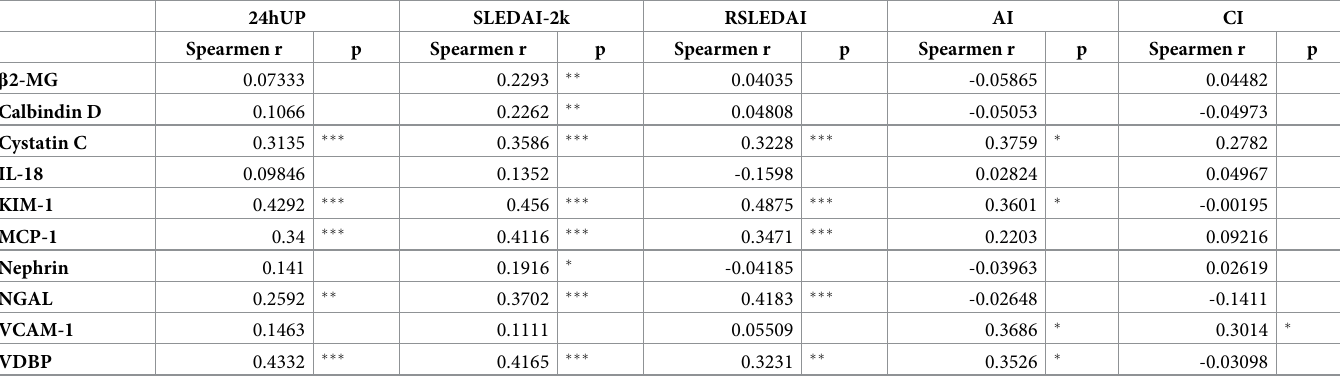
Table 3. Correlation of UBMs with disease activity scores.